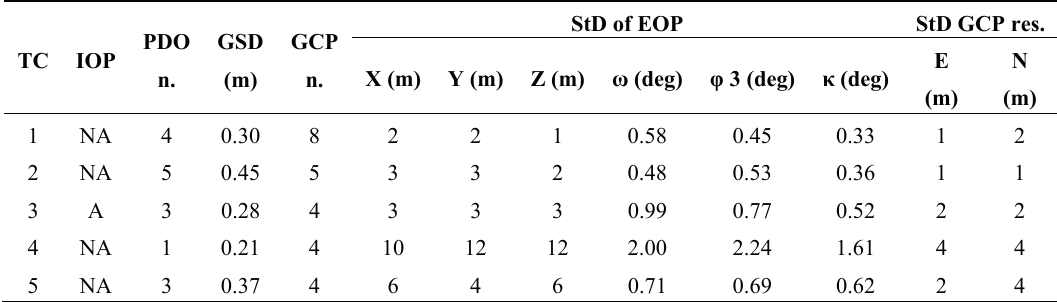
Table 6. Evaluation of the software performance: Test Cases (TC) numbered as in paragraph 4; Internal Orientation Parameters (IOP), Not-Available (NA) or Available (A); number (n.) of PDO for each test; ground resolution (GSD); number of GCP (GCP n.); Standard Deviation (StD) of GCP residuals: and Standard Deviation of External Orientation Parameters (StD of EOP). Average values on all the PDOs are reported for each